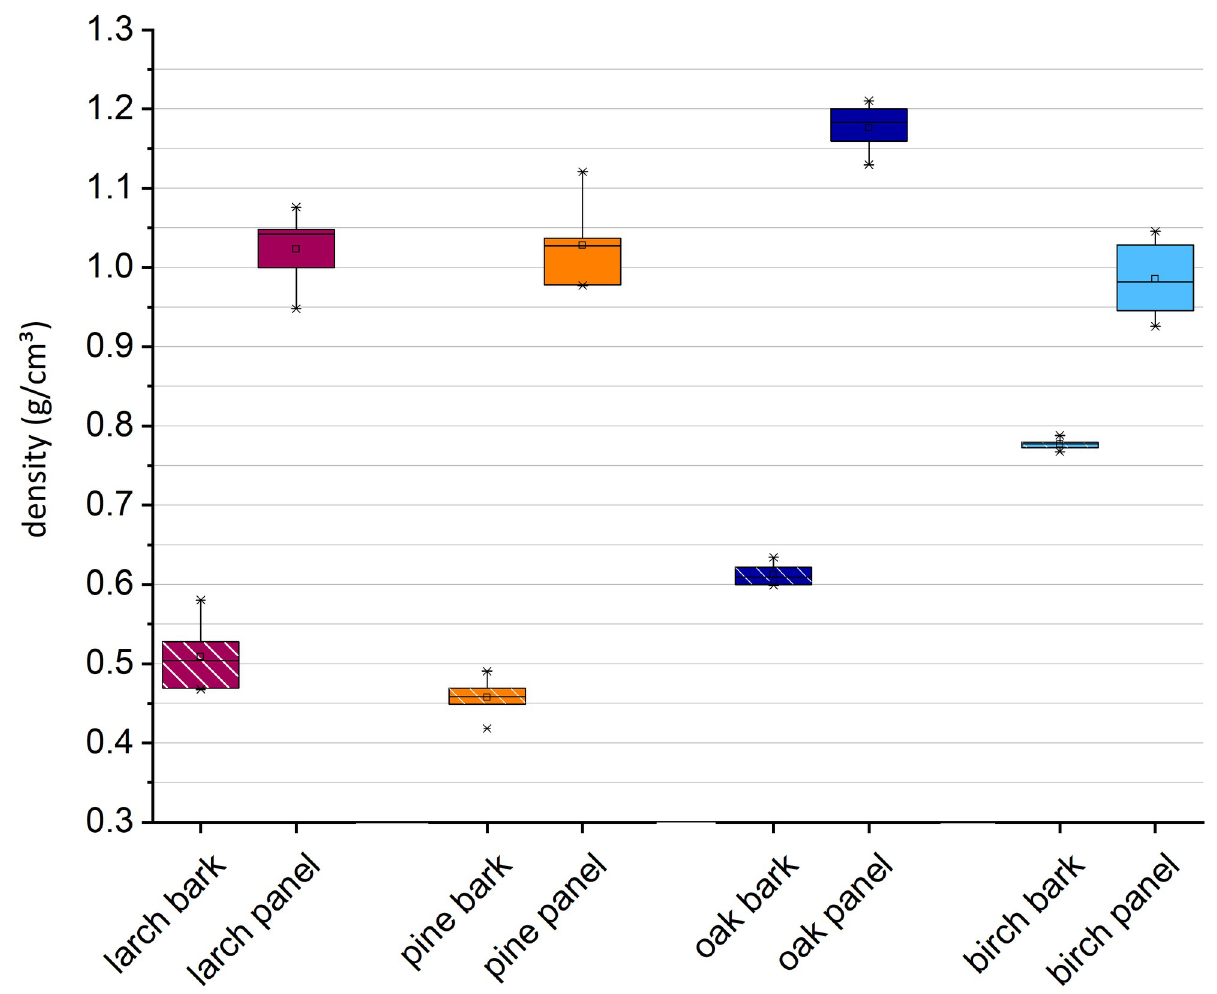
Fig 4. Densities of native bark pieces and compressed bark